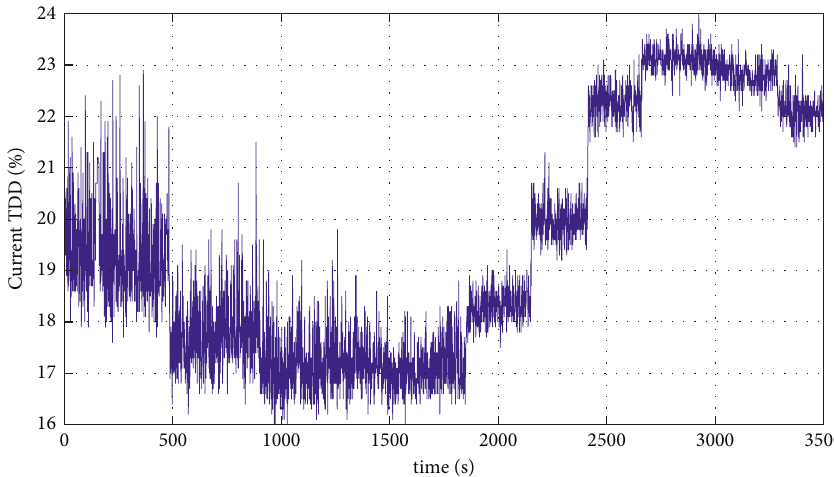
Figure 17: Total demand distortion rate (TDD) of